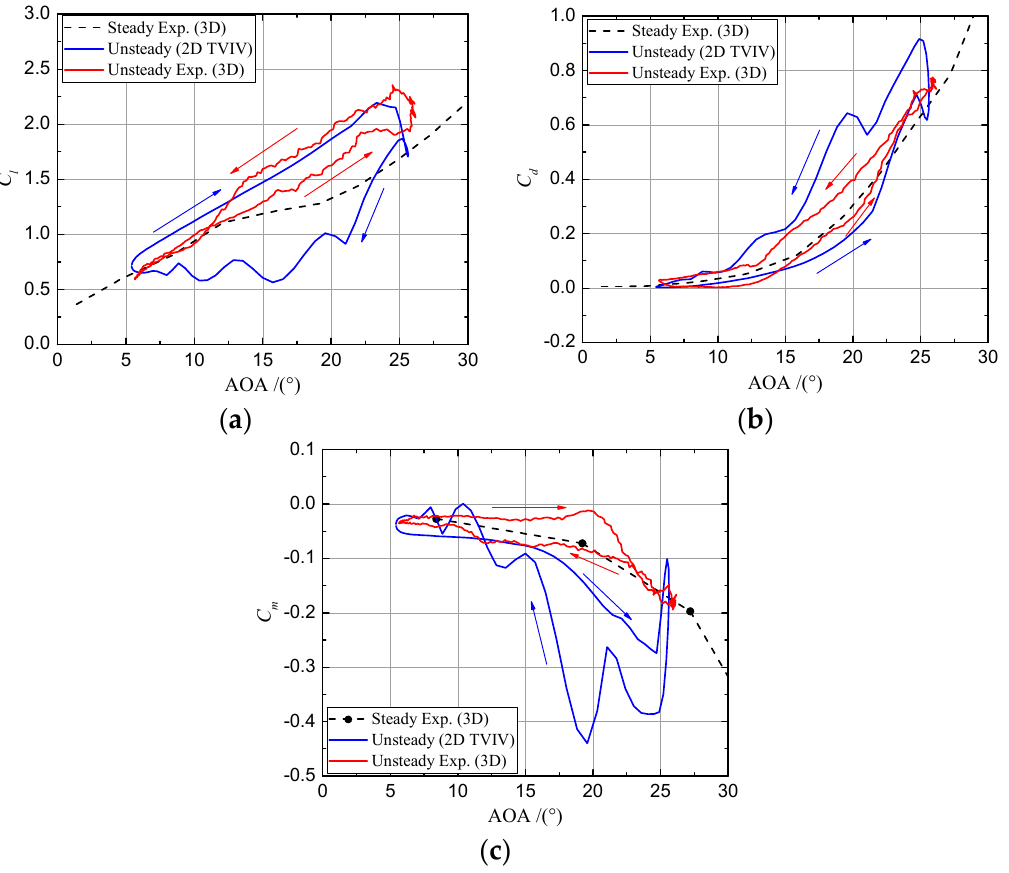
Figure 18. Hysteresis loops of the lift, drag, and pitching moment coefficients at 30° yaw angle. The wind speed is 10 m/s, and the spanwise location is 30%. ( a ) The lift coefficient; ( b ) The drag coefficient; ( c ) The pitching moment coefficient.